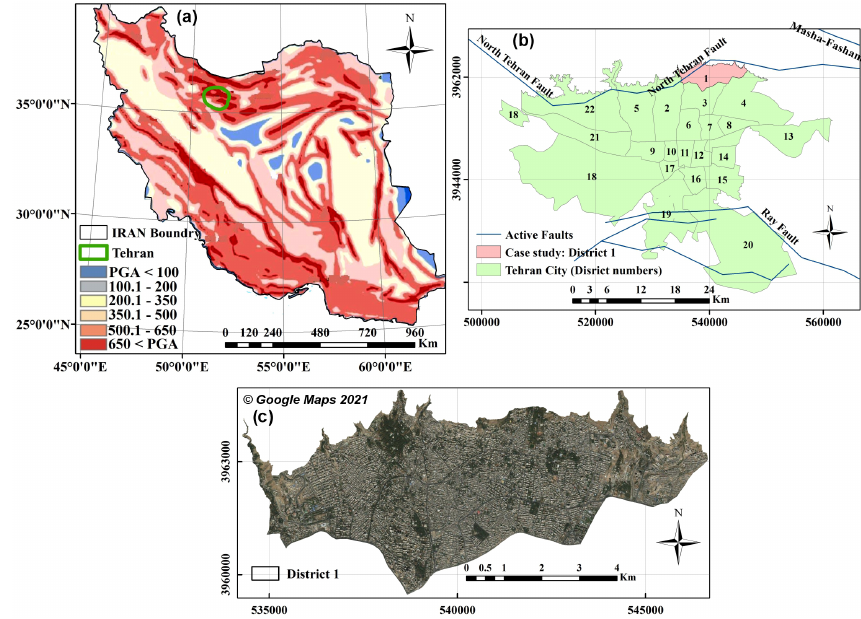
Figure 1. Location of case study: (a) peak ground acceleration map of Iran for a return period of 2475 years and approximate location of Tehran and (b) location of District 1 and active faults in Tehran. (c) Map of District 1 (study area) and active faults,